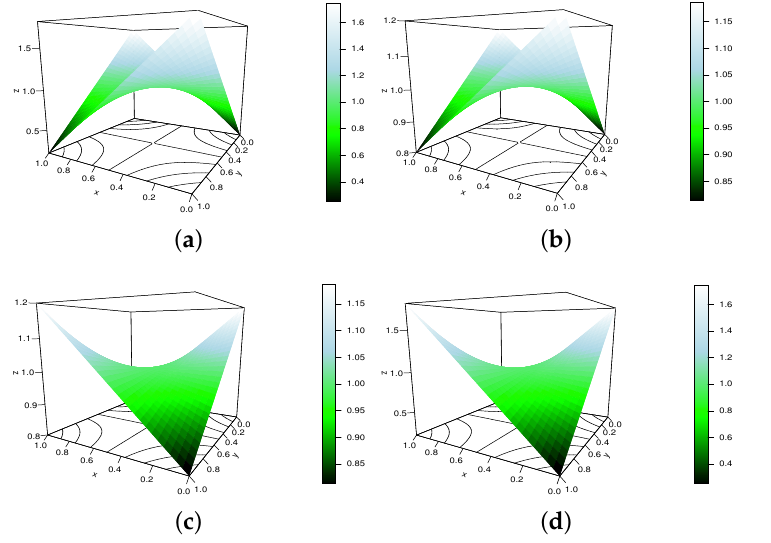
Figure 8. Display of the HAS copula density for β = 1, γ = 1, and ( a ) α = − 0.8, ( b ) α = − 0.2, ( c ) α = 0.2 and ( d ) α =